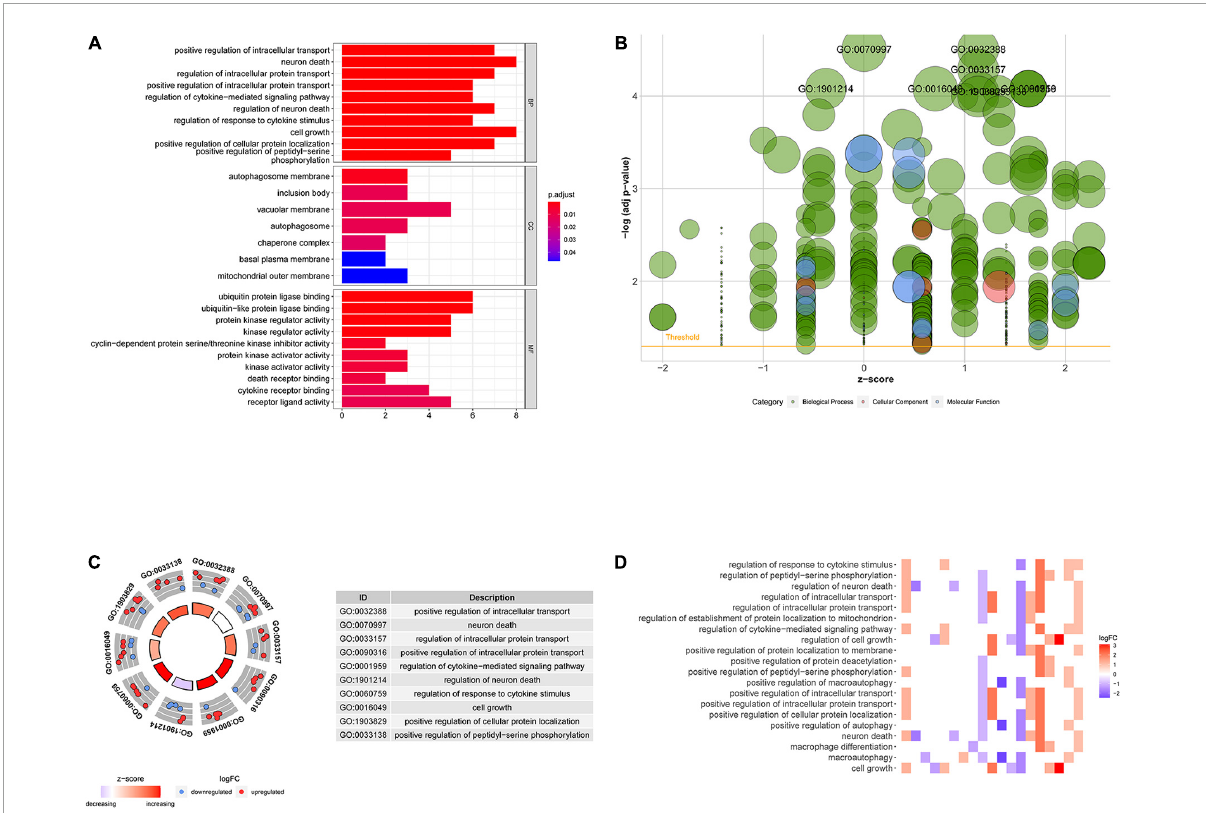
FIGURE3 Gene ontology (GO) analysis of differentially expressed NRGs. (A) Histogram demonstrating the top 10 enrichment pathways in biological process (BP), cellular component (CC), molecular function (MF); (B) bubble plot of GO terms; red denotes cellular components, green denotes biological processes and blue denotes molecular functions; (C) circle diagram demonstrating the top 10 significant enriched pathways; (D) heatmap demonstrating the relationship between NRGs and GO enrichment. The color of each block represents the | log2 (FC)| values.